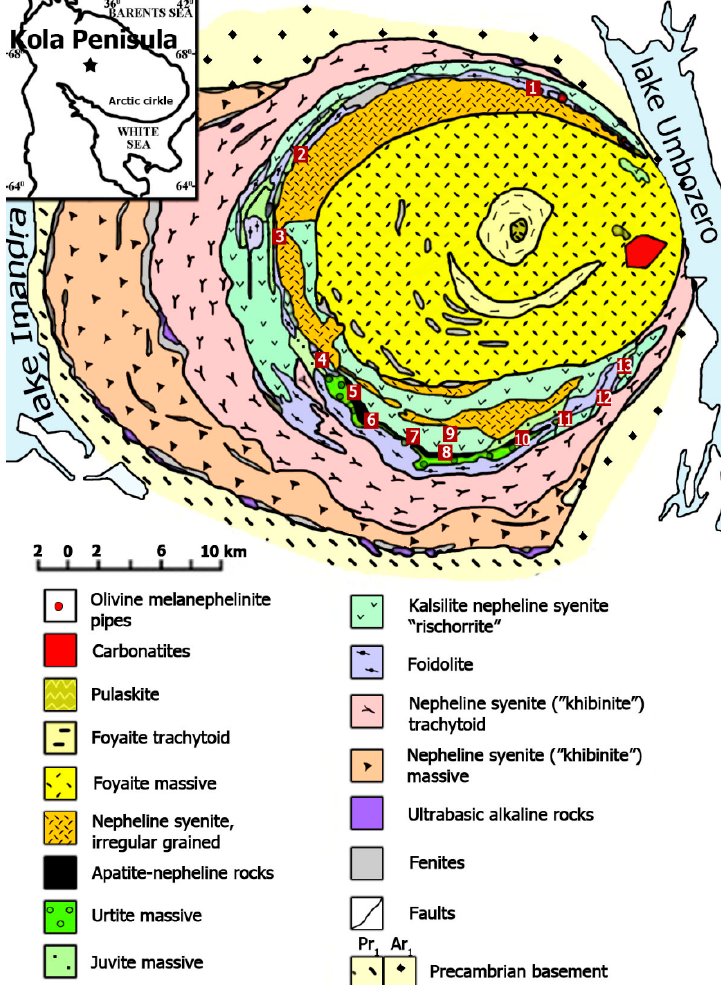
Figure 1. Geological map of the Khibiny massif generalized from the map of MGRE PGO “Sevzapgeologiya” (V.P.Pavlov) [2]. The geology of the Khibiny alkaline massif modified after using data from, and include references here [2].